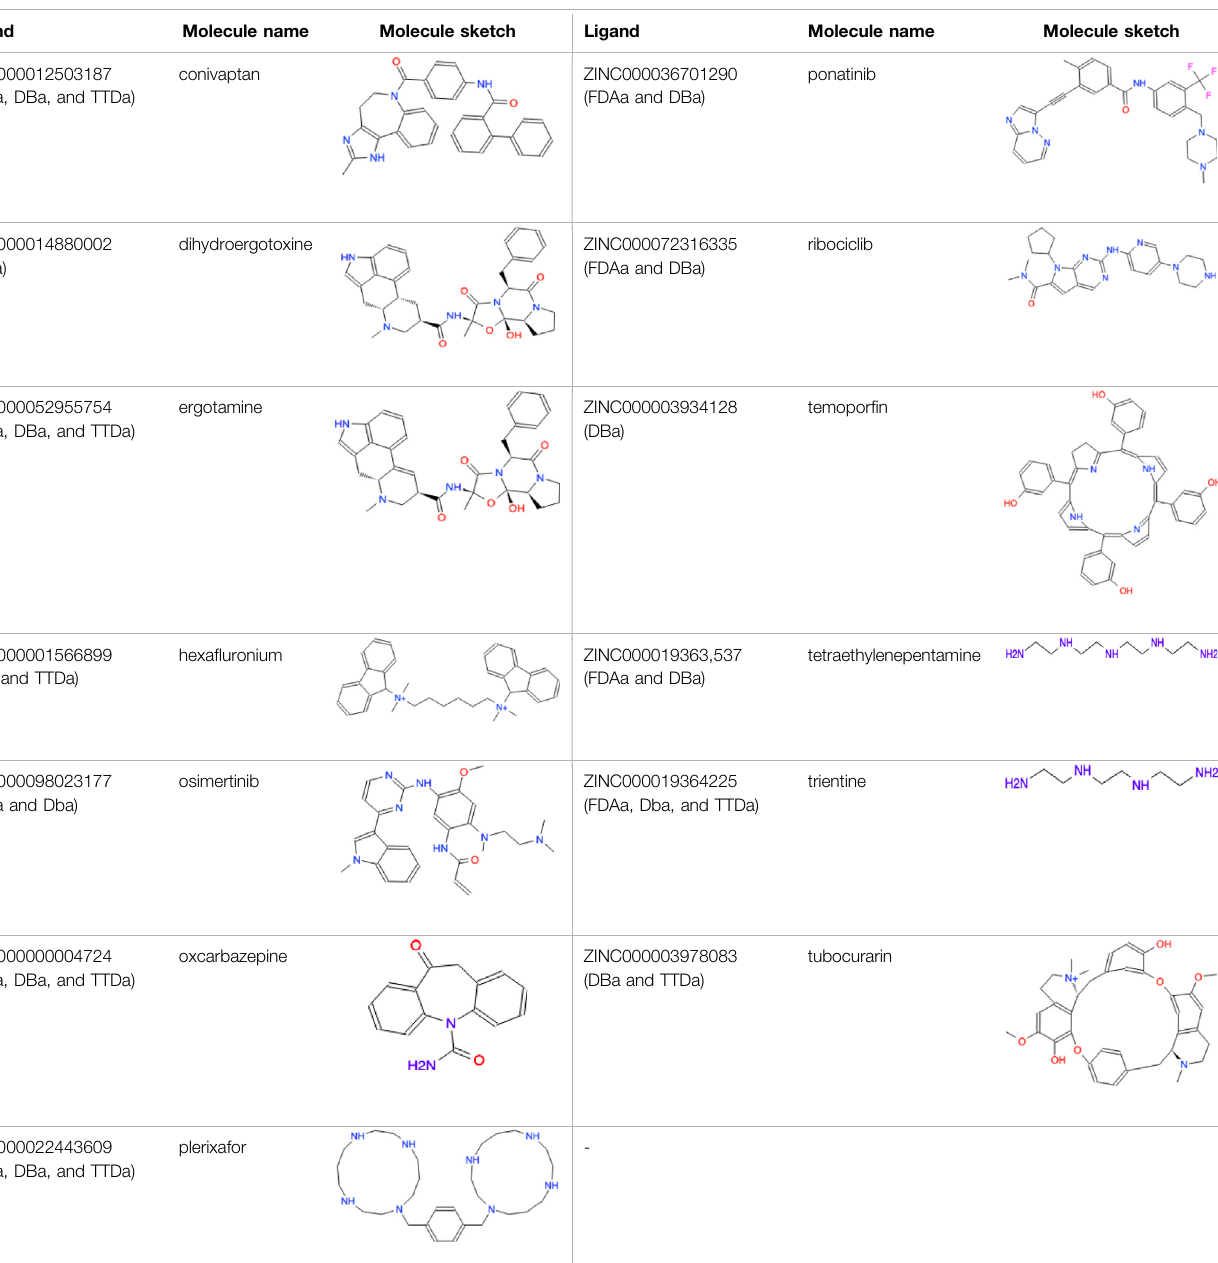
TABLE 1 | Selected